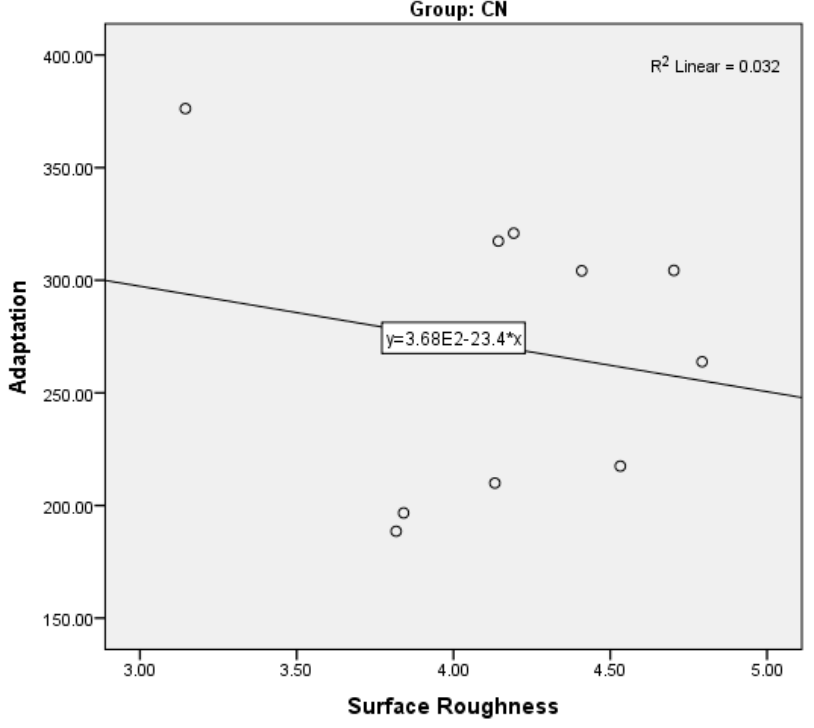
Figure 10. Scatter plot for the correlation between adaptation and surface roughness for the CN samples. Figure 11 for Group CC shows a positive correlation between surface roughness and marginal misfit, with a 14.2% variation in misfit. However, it was statistically insignificant, with a p -value of